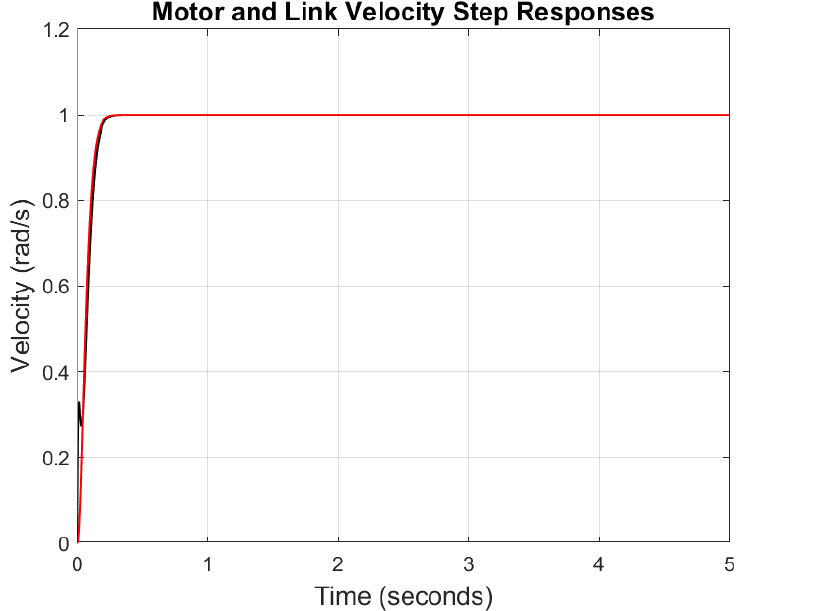
Figure 13. Velocity Motor and Link time responses—Black line: Motor; Dashed Red line: Link.